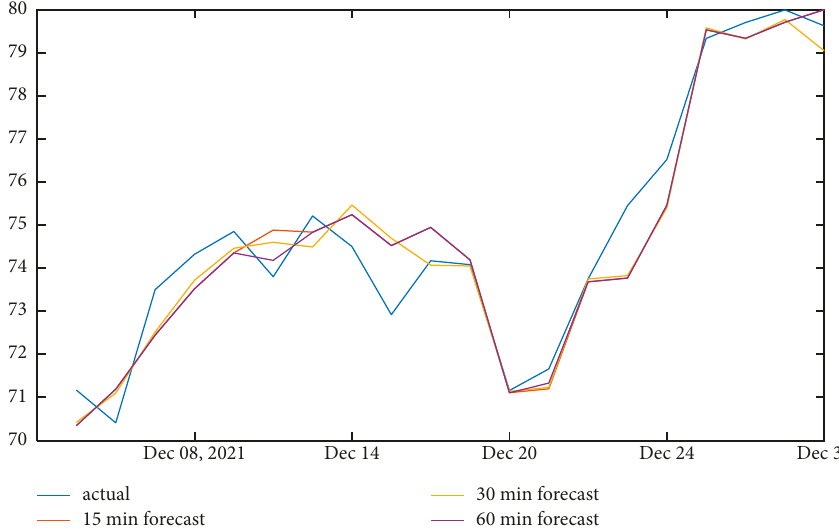
Figure 7: Actual and forecast price (USD per barrel) in different frequencies with night trading (after May, 2020). Table 5: Comparison of deviation degree and deviation distance in different periods.